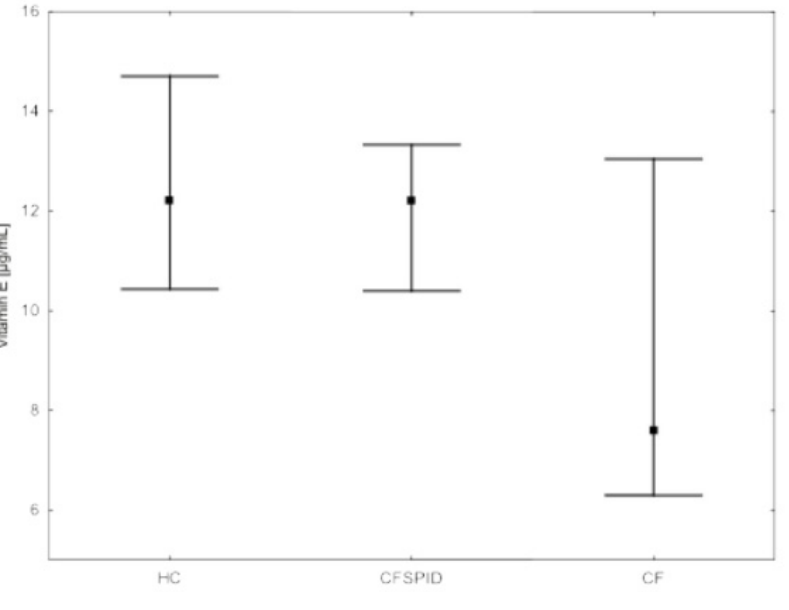
Figure 2. Vitamin E blood concentration among CF, CFSPID, and HC. Table 4. Distribution of the content of vitamins A, D, E, and C in diets of particular groups. CFSPID CF